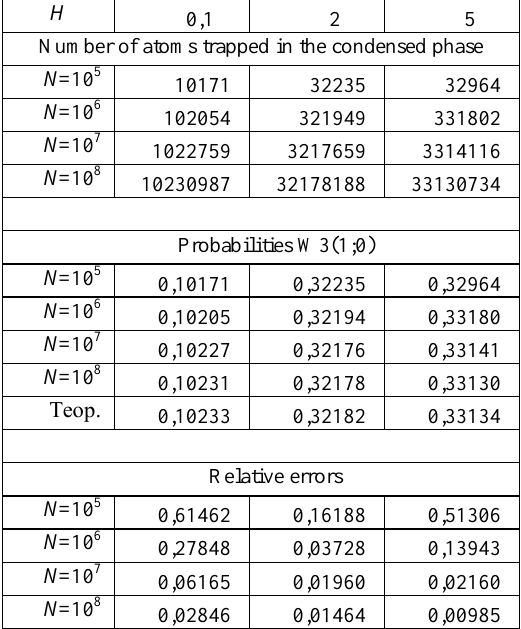
Table 5. The probability of atoms entering the condensed phase W3(1;